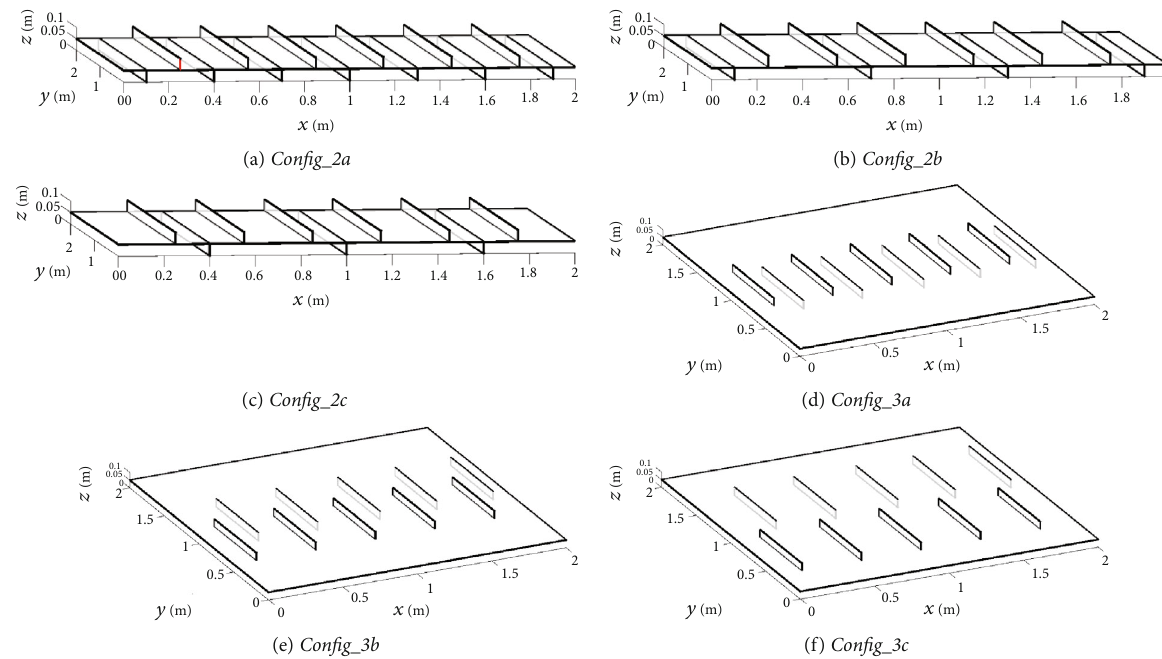
Figure 6: Deterministic fracture networks representing strata-bound, bed-normal joint sets in layered carbonate rocks. Joint networks considering (a – c) spacing contrast in adjacent beds and (d – f) overlapping pattern of joint sets in adjacent